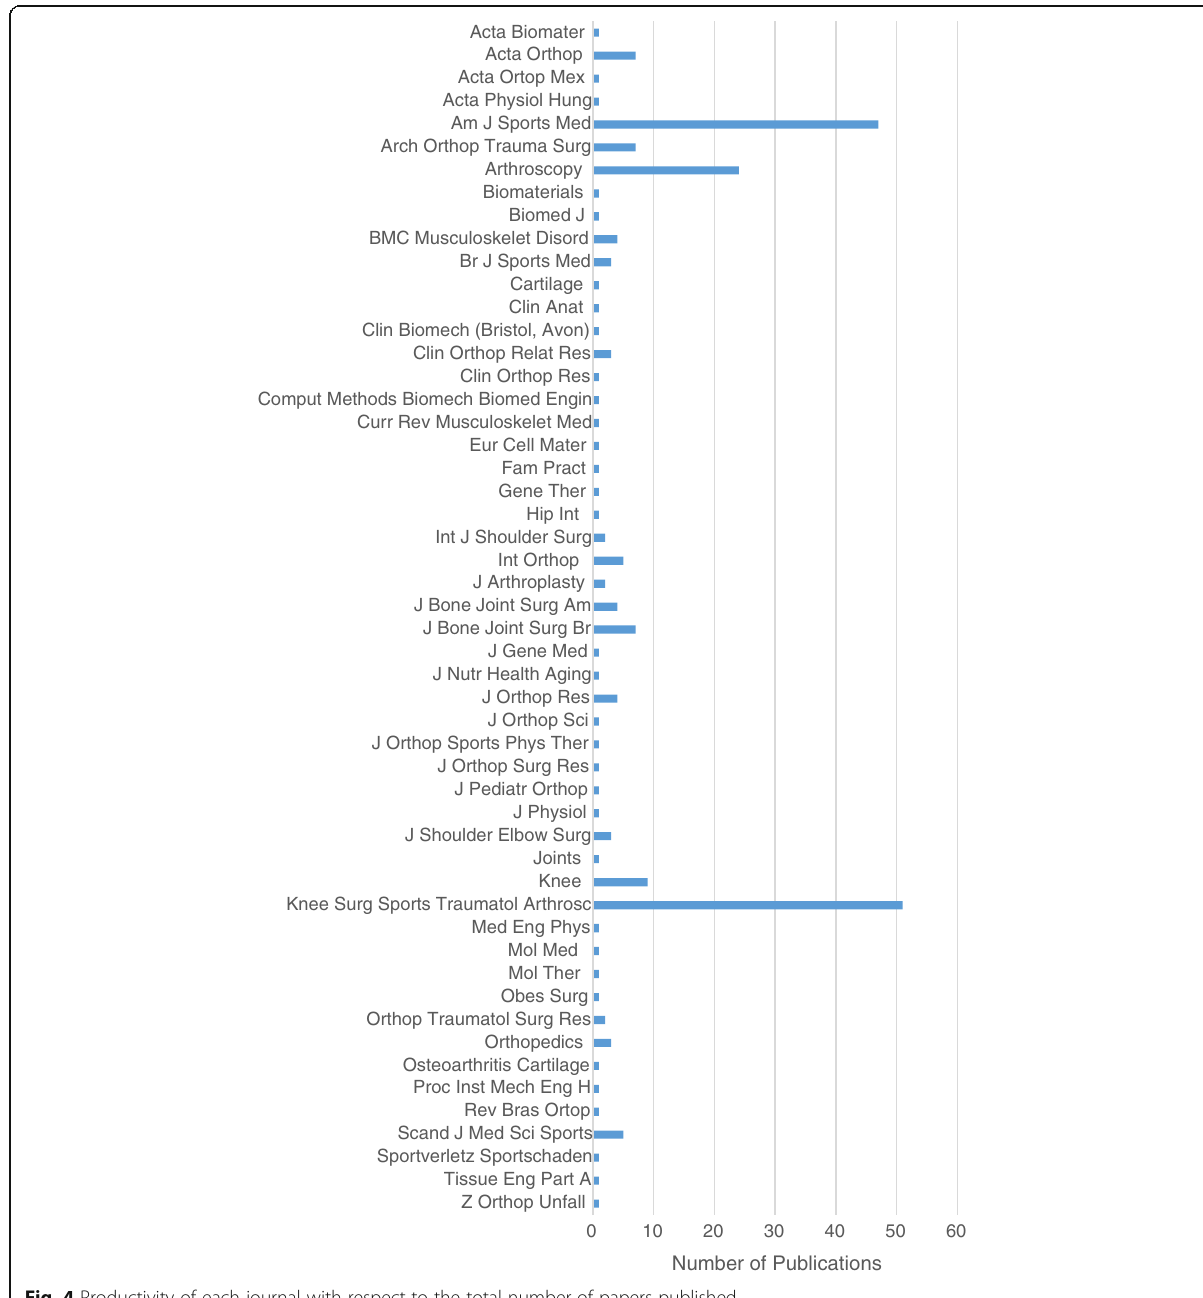
Fig. 4 Productivity of each journal with respect to the total number of papers